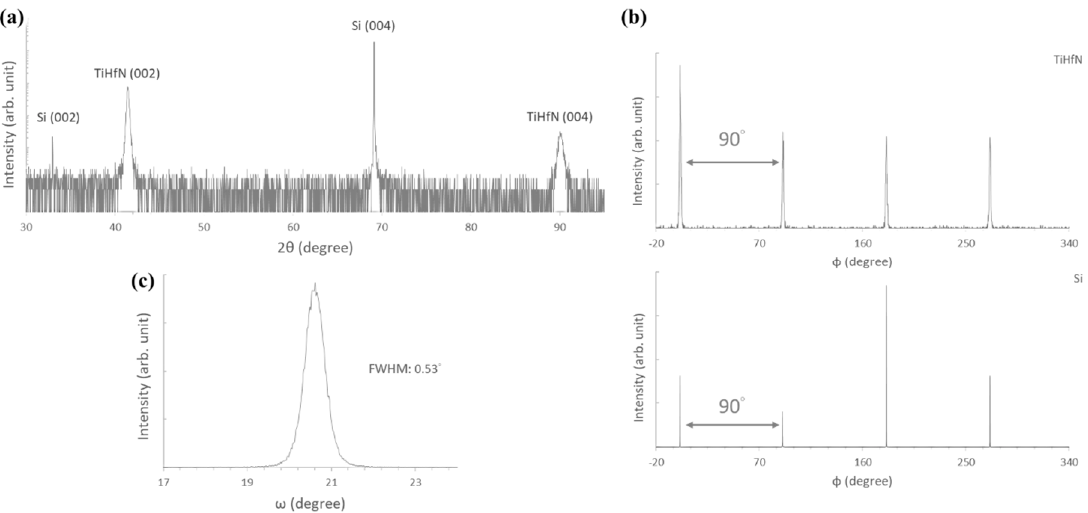
Figure 2. XRD analyses of the annealed TiHfN/Si sample. ( a ) 2 θ−ω pattern, ( b ) ϕ− scan patterns of {113} TiHfN and {113} Si reflections and ( c ) (002) TiHfN rocking curve.